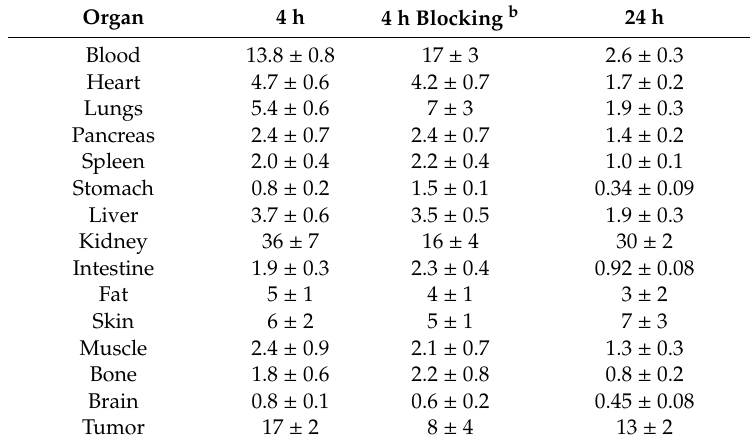
Table 3. Biodistribution of [ 55 Co]Co-cm10 in KB tumor bearing mice a .